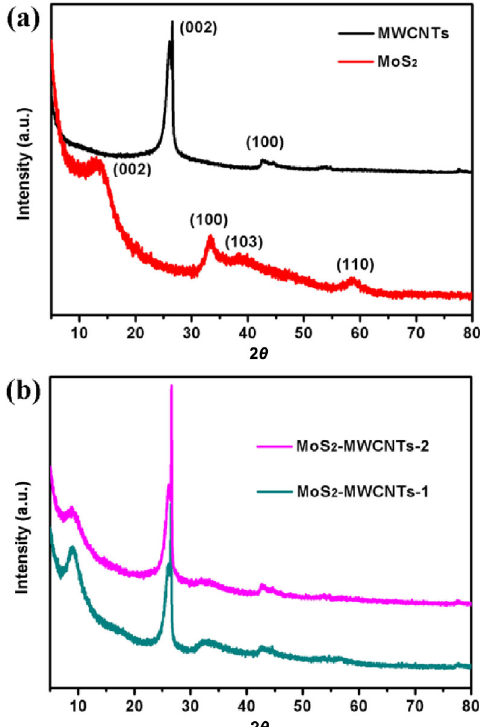
Fig. 2 XRD patterns of MoS 2 , MWCNTs, and MoS 2 -MWCNT hybrid.